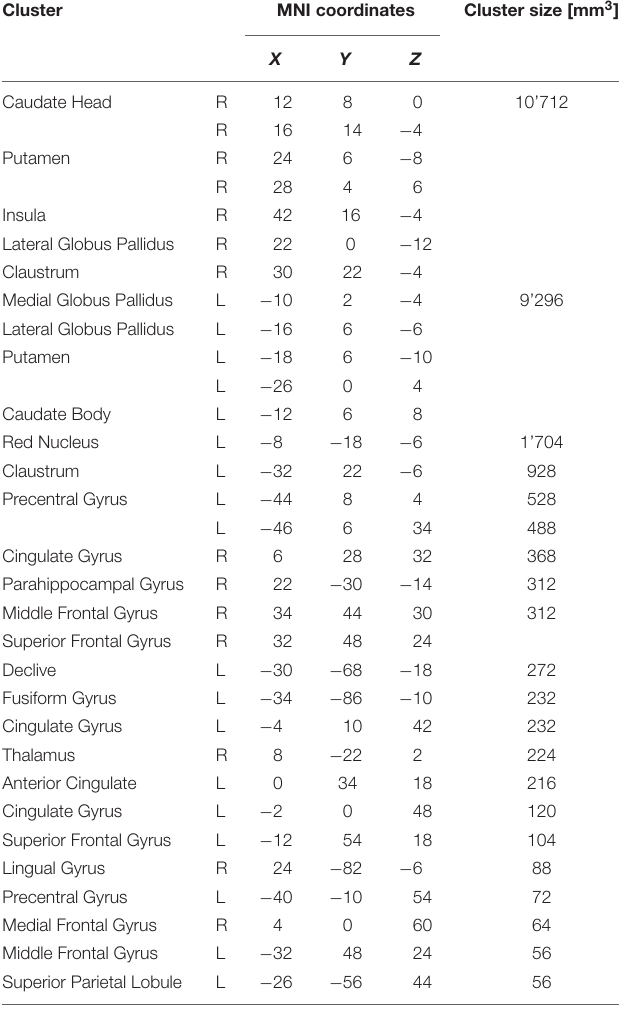
TABLE 2 | Details of the clusters revealed by the analysis across all